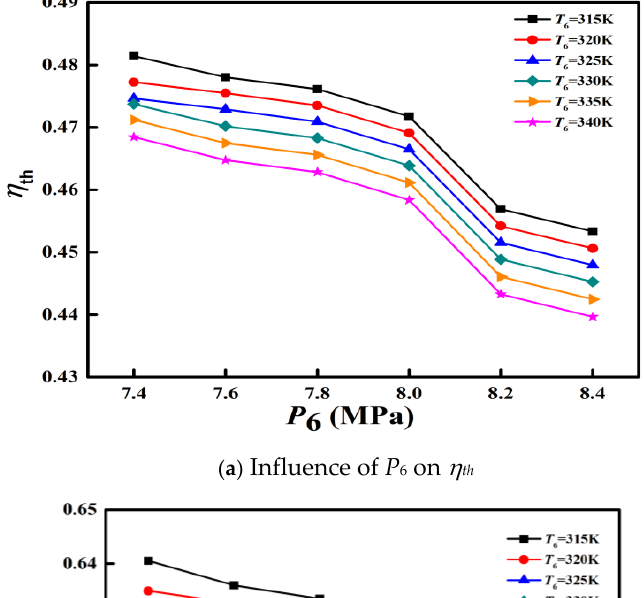
Figure 10 indicates the cycle performance variation at different P 6 , T 2 = 1200 K, x = 0.3, and π = 3.0.